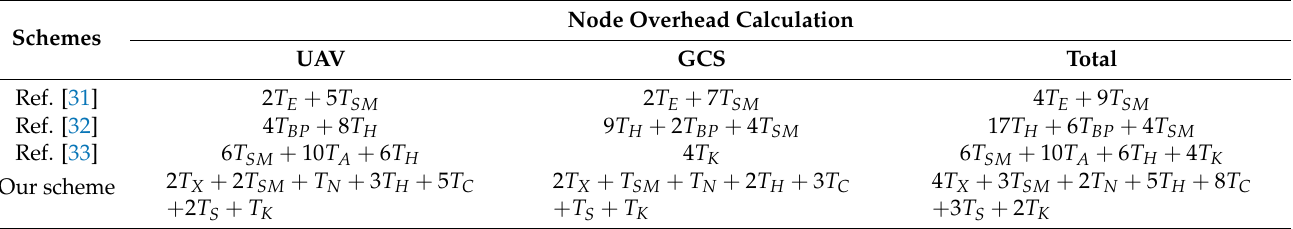
Table 10. Comparison of node computation